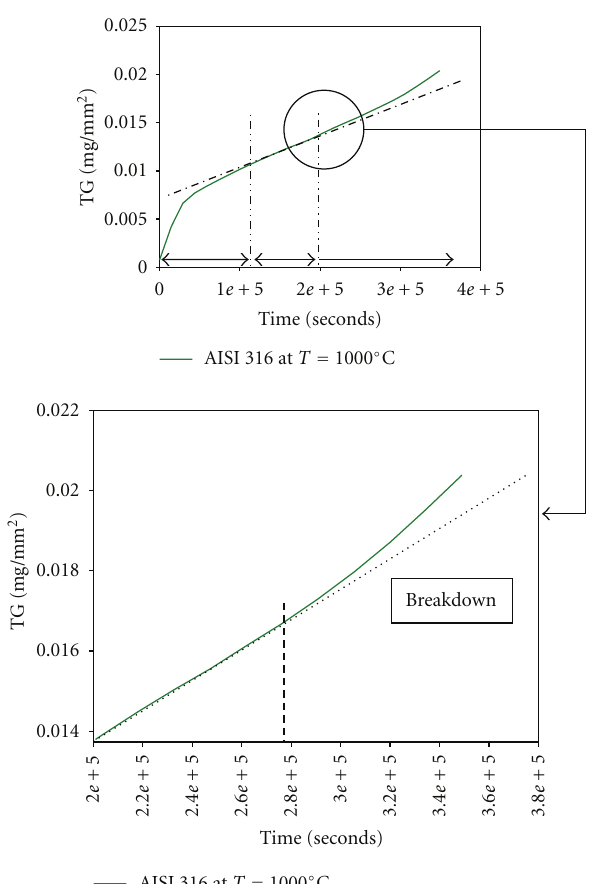
Figure 2: The scale breakdown obtained of AISI 316 at T = 1000 ◦ C in synthetic